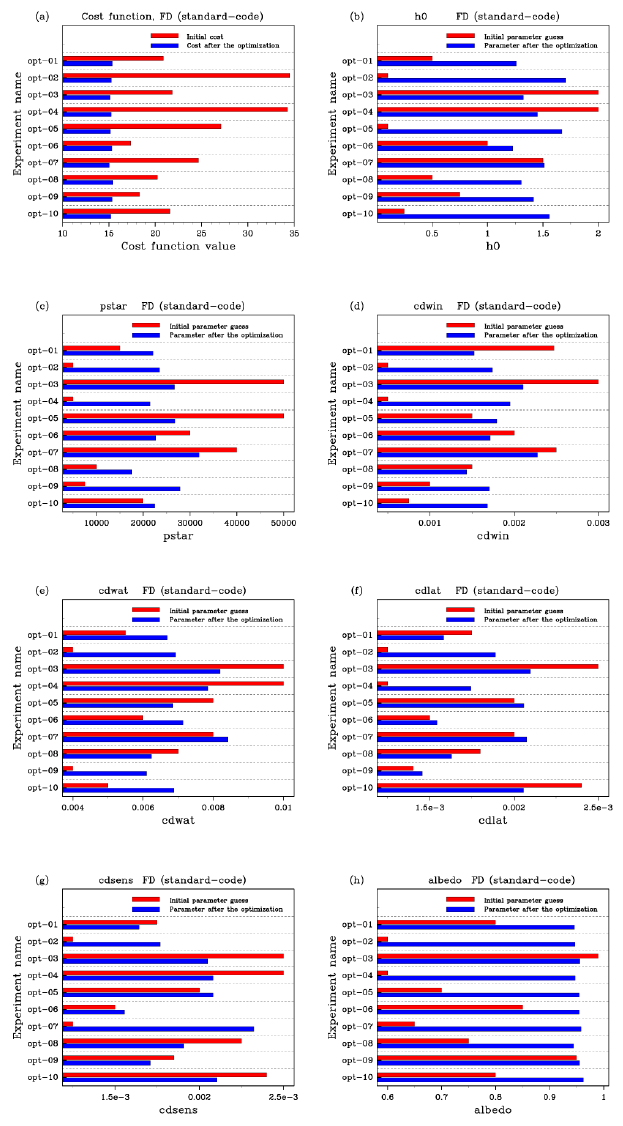
Fig. 9. The initial and optimized cost functions and associated pa- rameter values obtained from 10 independent optimization exper- iments with the finite difference method using the standard-code. (a) Initial (red) and optimized (blue) cost function values. (b–h) Ini- tial (red) and optimized (blue) parameter values: (b) h 0 , (c) P ∗ , (d) cdwin , (e) cdwat , (f) cdlat , (g) cdsens and (h) albedo